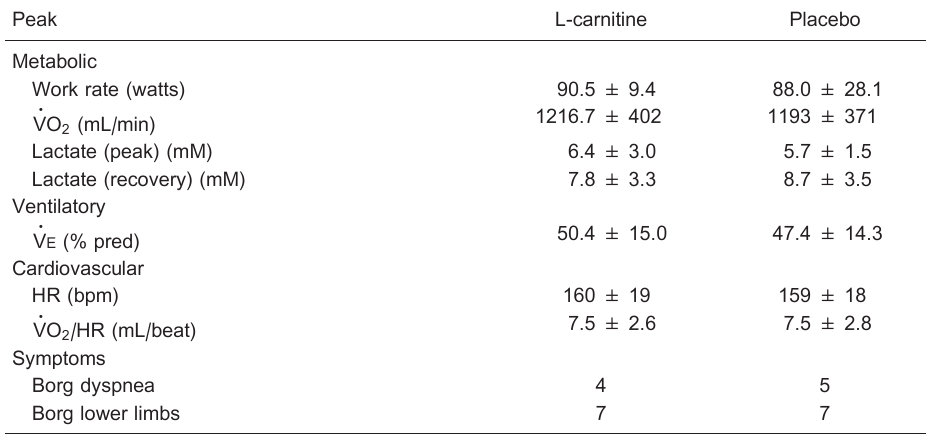
Table 5. Exercise responses of the patients with mitochondrial myopathy during the incremental cardiopulmonary exercise test, after L-carnitine or placebo supplementation at peak exercise. Peak